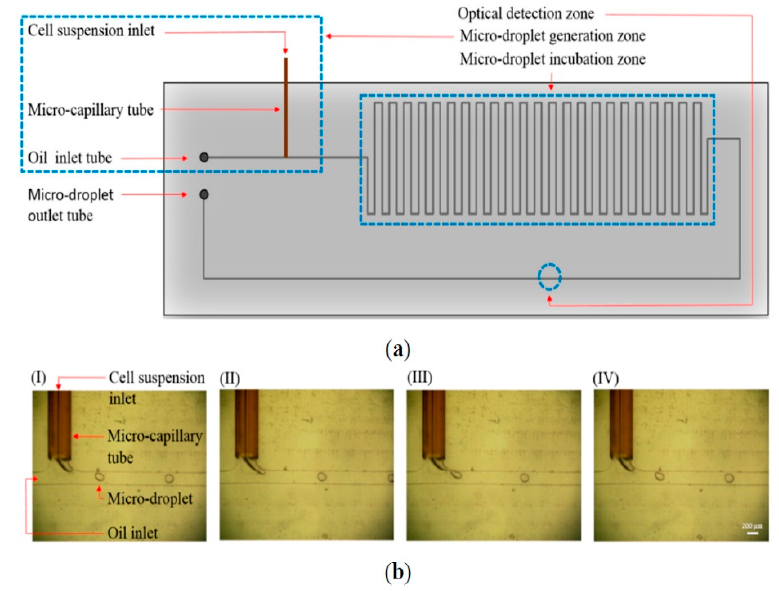
Figure13. ( a )Schematicillustrationofthemicrodevice(top-viewlayout). ( b )Photographsofcontinuous Figure 13. ( a ) Schematic illustration of the microdevice (top-view layout). ( b ) Photographs of micro-droplet generation process ((I)-(IV)) (Reprinted from continuous micro-droplet generation process ((I)-(IV)) (Reprinted from [74] ).